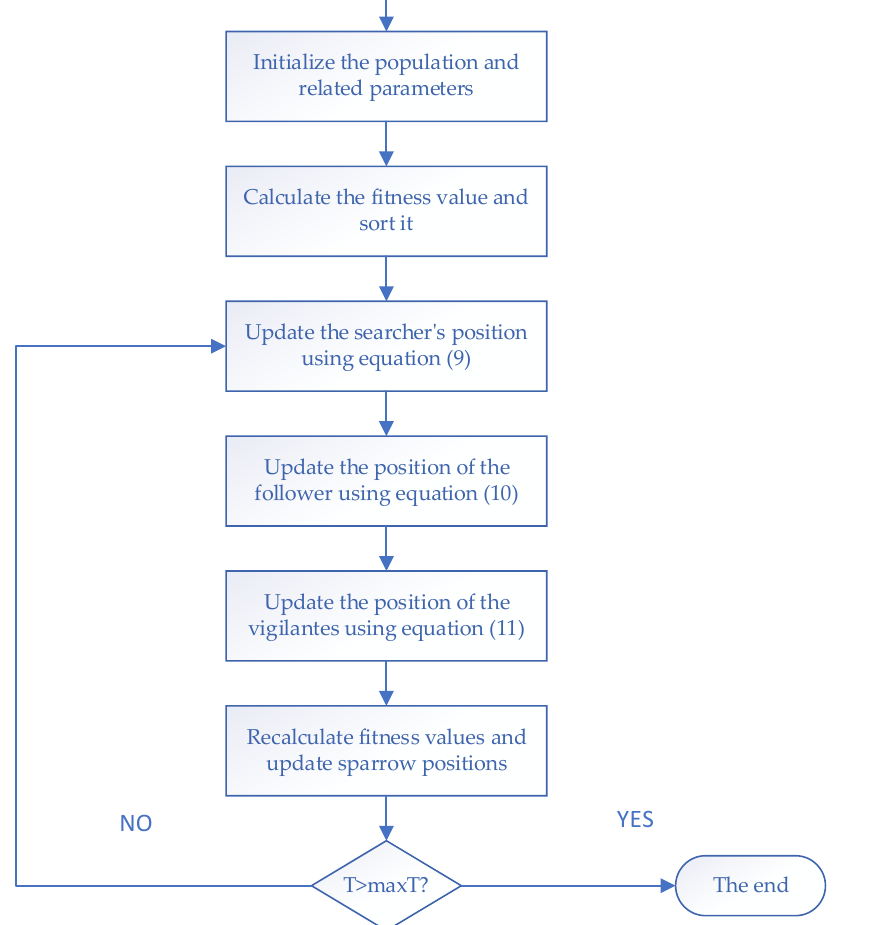
Figure 1. Block diagram of the SSA algorithm operation.